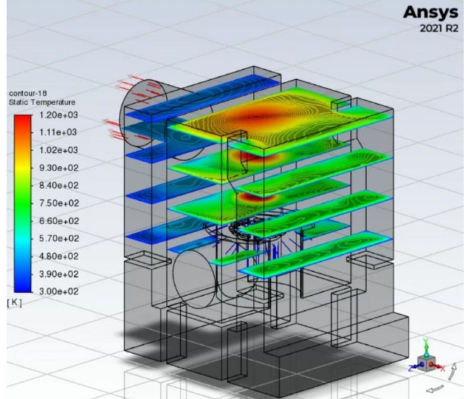
Figure 2. Temperature distribution